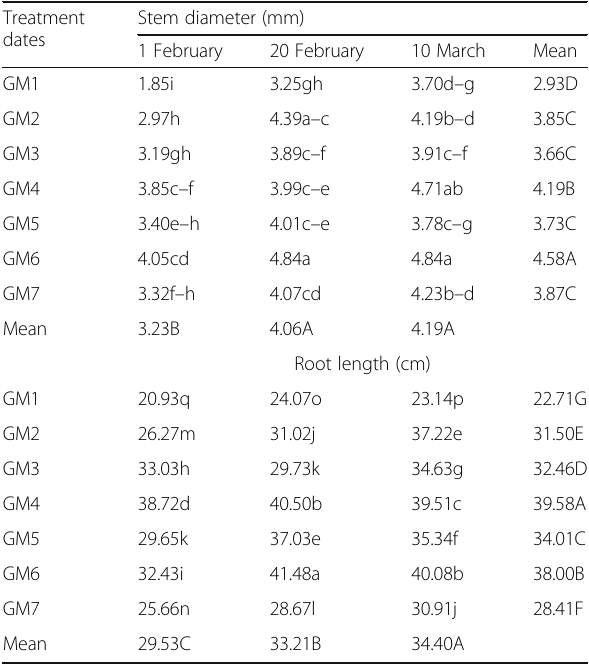
Table 5 Effect of planting dates and different growing media and the interactions between them on stem diameter and root length of pistachio